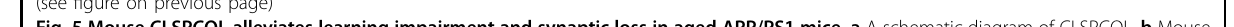
(Fig. 4h, comparing APP/PS1 + DW and APP/PS1 + CLSPCOL groups).